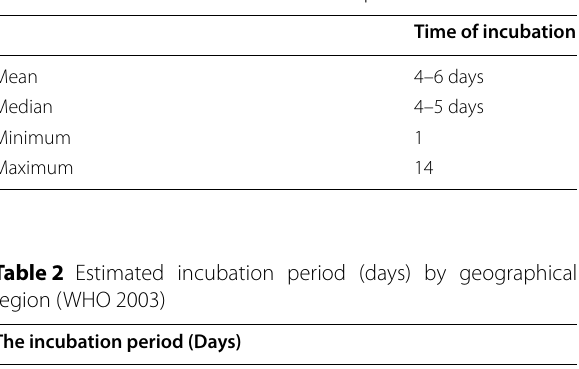
Table 1 Estimated time of incubation as per WHO consensus